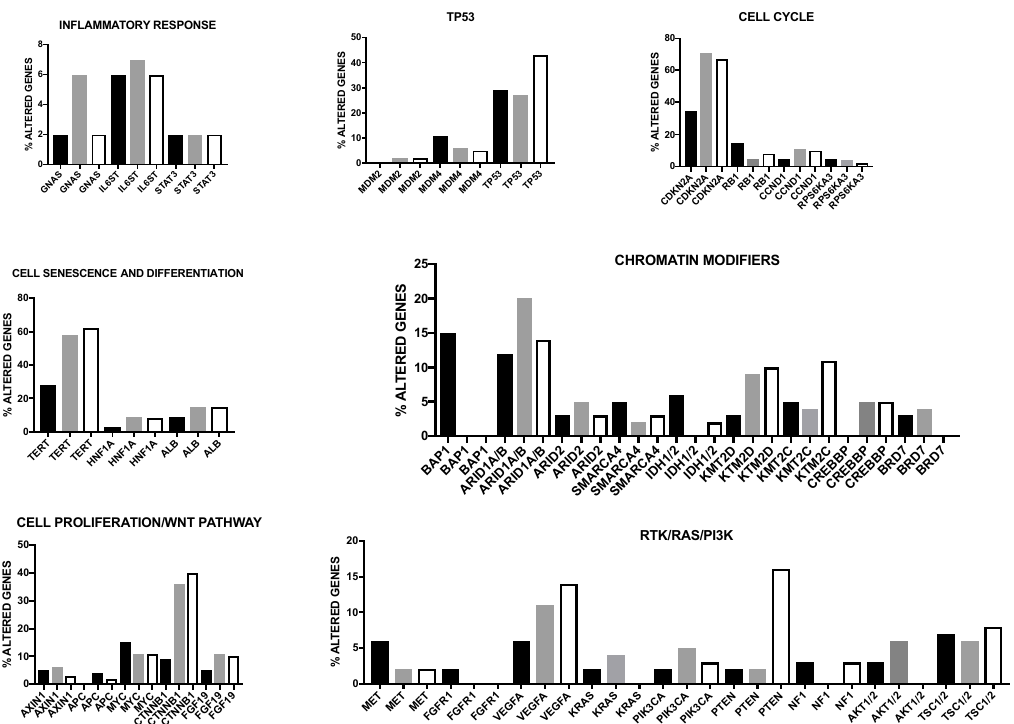
Figure 4. Integrated molecular analysis of somatic alterations in signaling pathways in HCC patients subdivided into three different clusters (cluster 1, black bars; cluster 2, gray bars; cluster 3, white bars). The data are reprinted from a recent study of the Cancer Genome Atlas Network [5]. Somatic alterations include mutations, copy number alterations and epigenetic silencing of